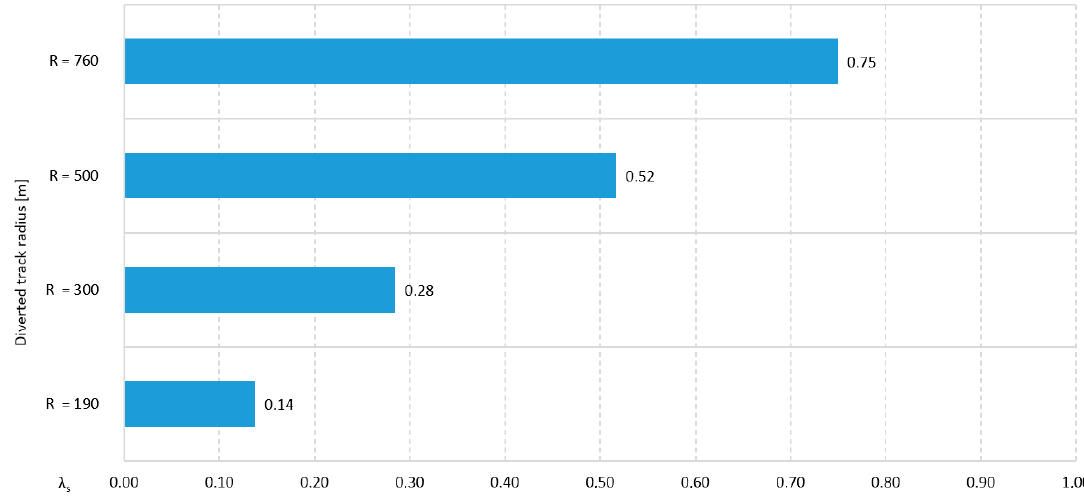
Figure 16. E ff ects of the curves of the diverted tracks on the service life of the Figure 16. Effects of the curves of the diverted tracks on the service life of the rail.